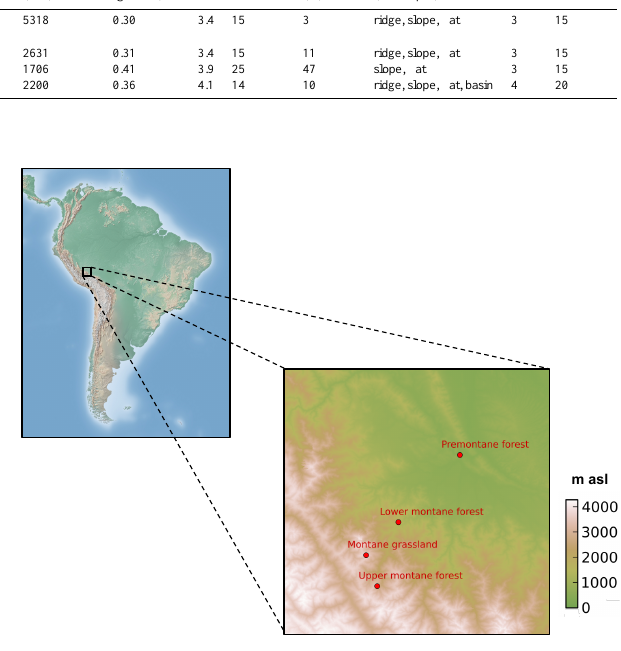
Fig. 1. Map of study sites across the Kosñipata Valley, Manu Na- tional Park,